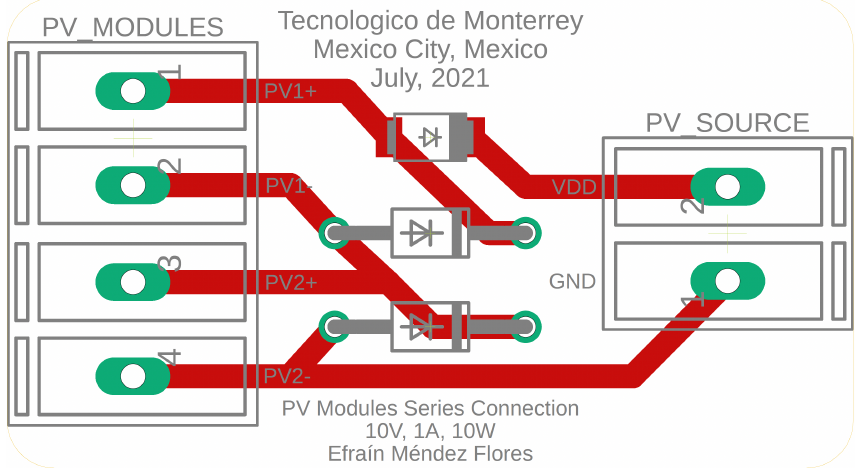
Figure 16. PCB layout design of the PV module integration